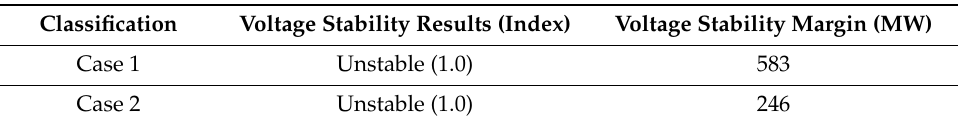
Table 4. Comparison of the Case 1 and Case 2.